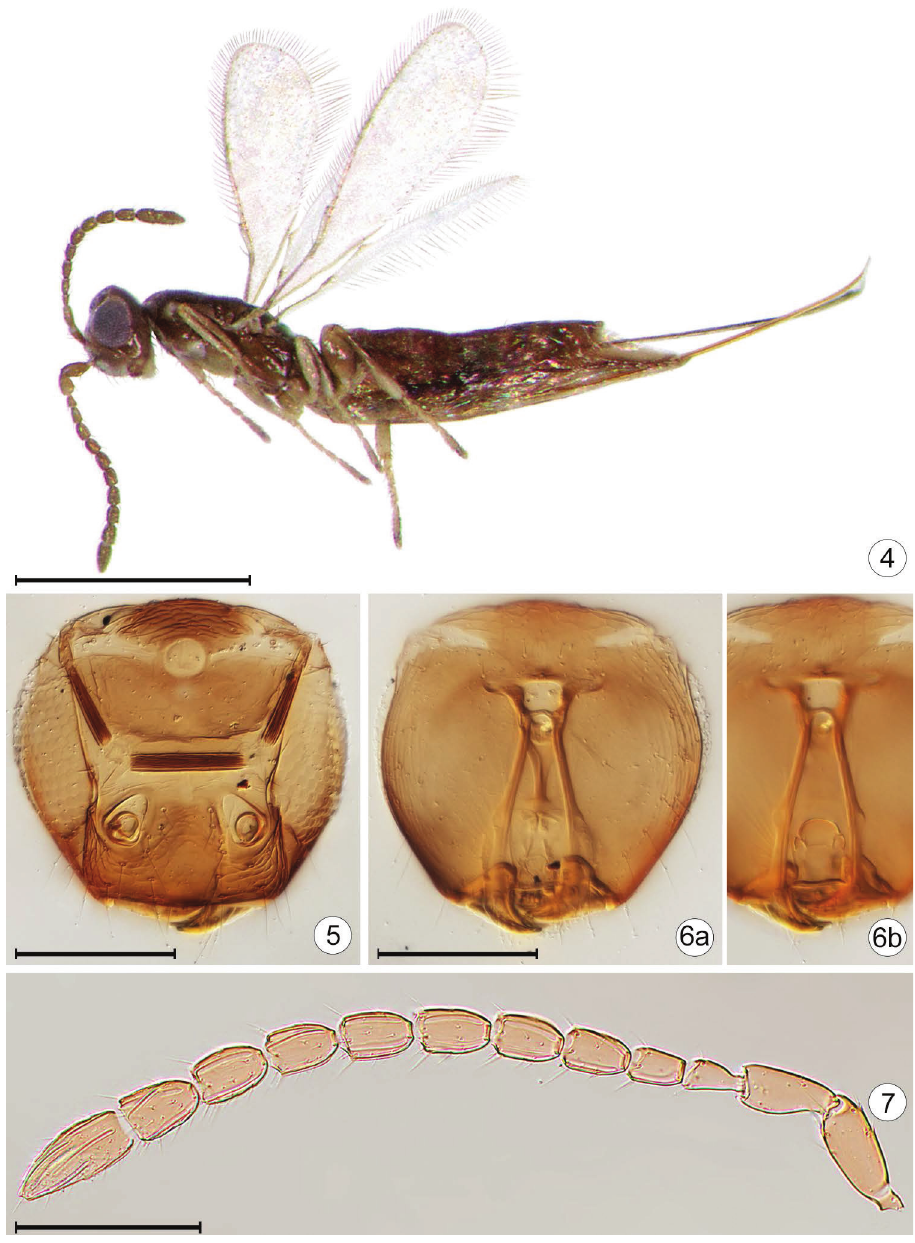
Figures 4–7. Eustochomorpha haeckeli , female. 4 habitus (Australia, WA, Stirling Range National Park) 5 head, anterior; 6a head, posterior 6b tentorium 7 antenna. Scale bar for 4 = 500 μm; 5–7 = 100